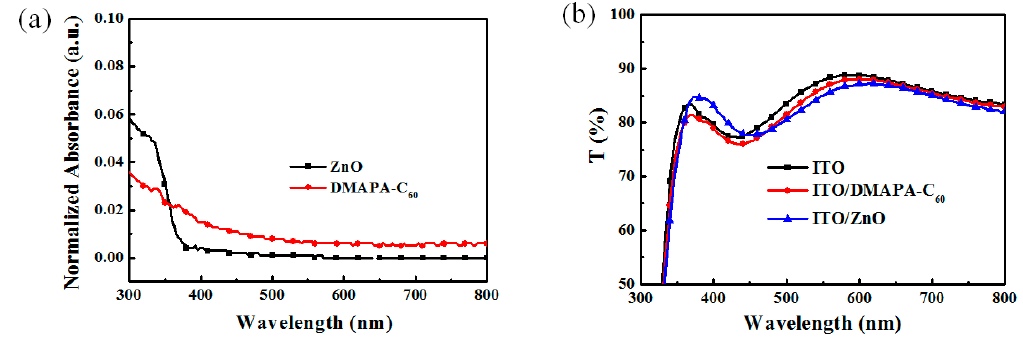
Figure 2. ( a ) UV-Vis absorption spectra of ZnO and DMAPA-C 60 films; ( b ) Transmittance spectra of ITO, ITO/DMAPA-C 60 , and ITO/ZnO films.